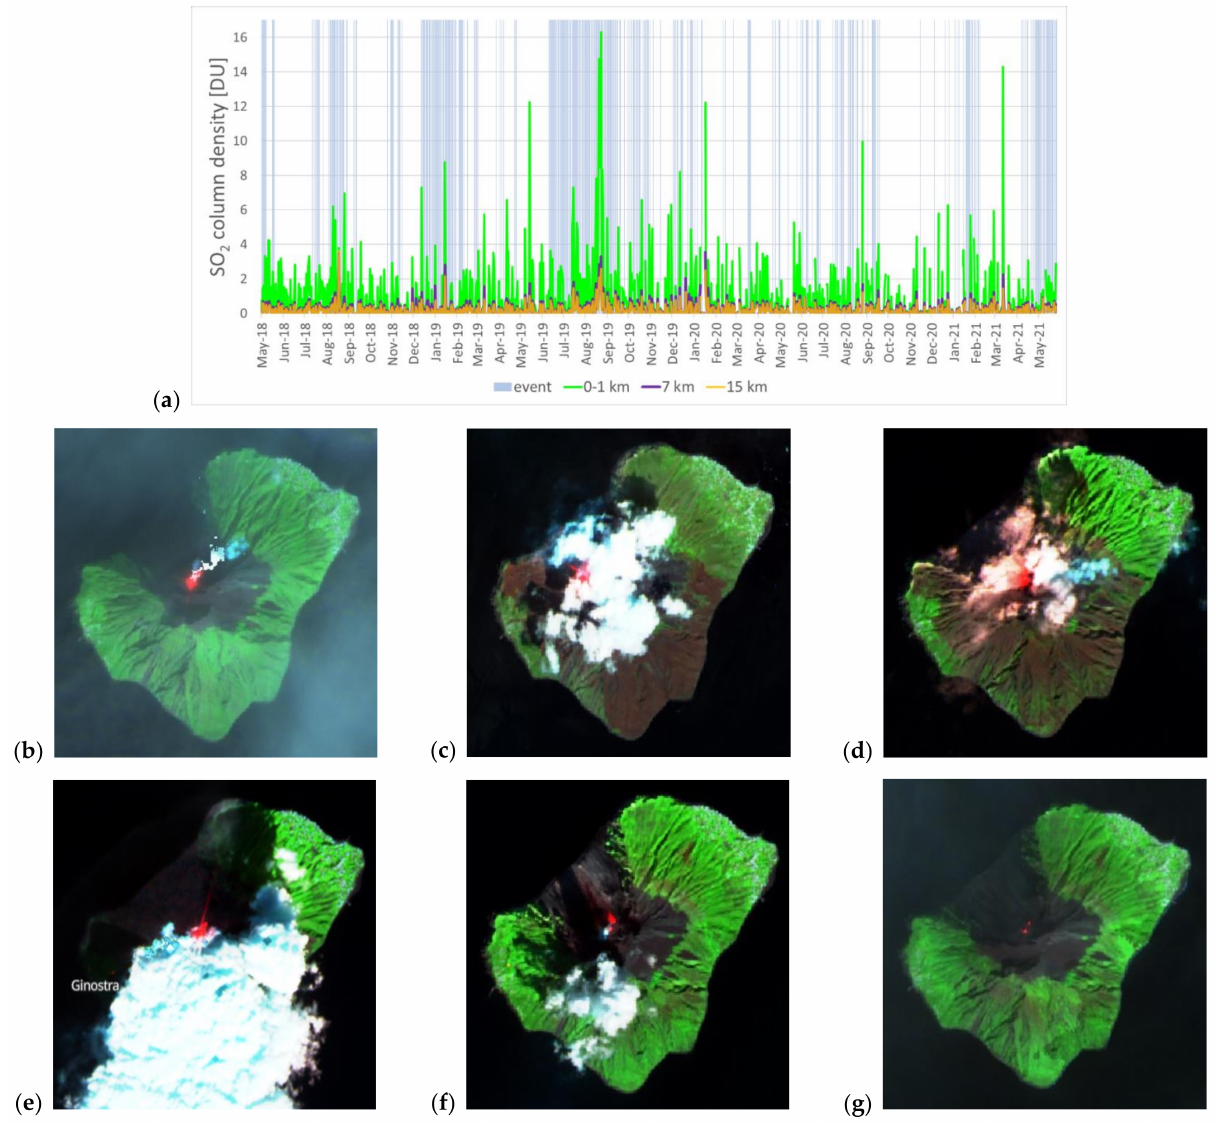
Figure 5. ( a ) Comparison of TROPOMI total SO 2 vertical column density at the main crater of Stromboli for three volcanic scenarios (i.e., plume located at ground level or 7 or 15 km altitude). Sentinel-2 false color composites (R: band 12—short- wave infrared; G: band 8A—red edge; B: band 4—red) for: ( b ) 18 January 2019, ( c ) 26 August 2019, ( d ) 18 January 2020, Sentinel Hub